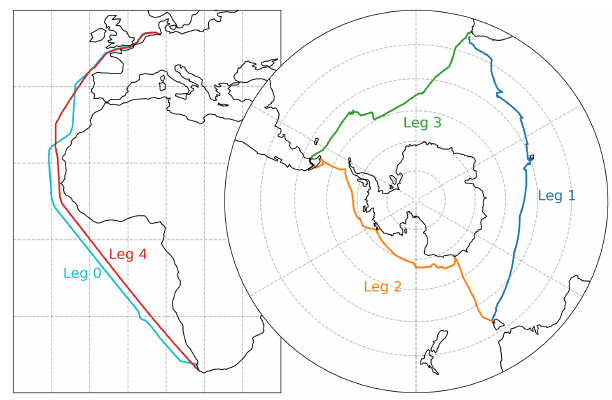
Figure 1. Map showing the track of the R/V Akademik Tryoshnikov . Legs 0–4 are shown using different